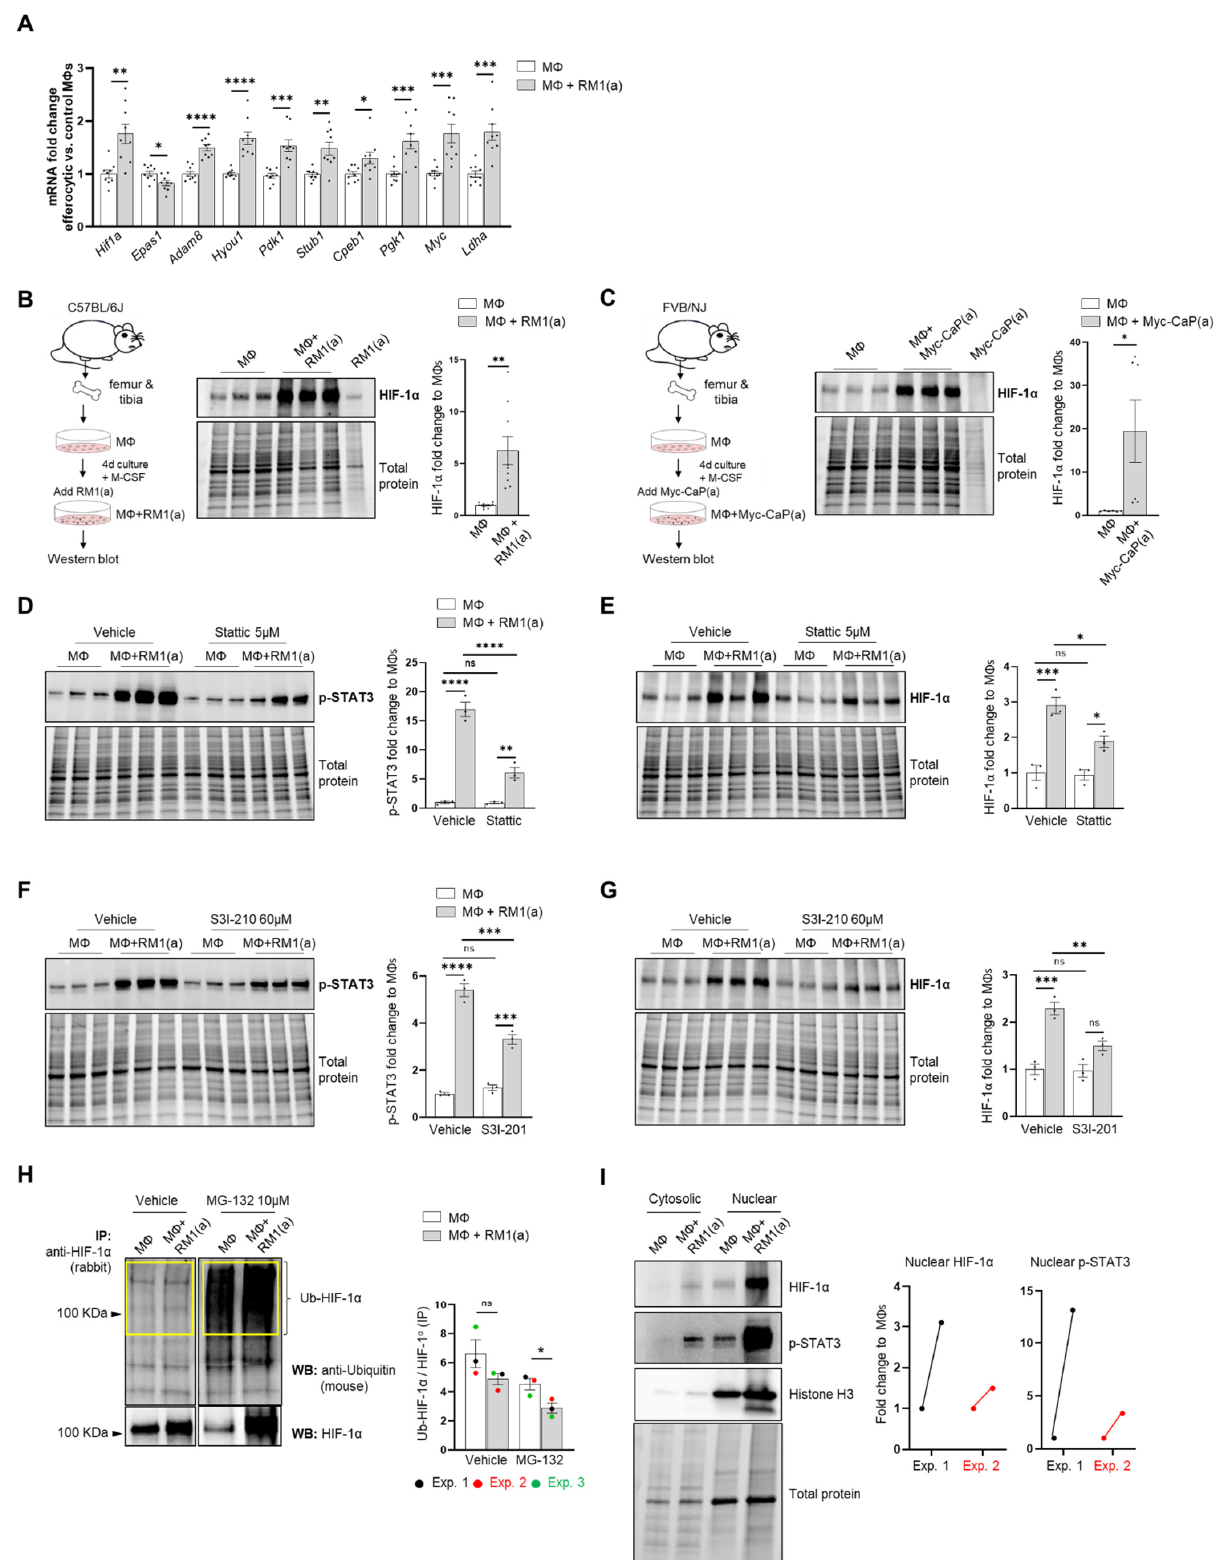
Figure 2. BM macrophage efferocytosis of apoptotic cancer cells promotes HIF-1 α stabilization through STAT3 activation. BM macrophages (M Φ ) were isolated from 4 wk old C57BL/6J or FVB/NJ mice and co-cultured with apoptotic RM1(a) or Myc-CaP(a) cells for 16–18 h. ( A ) mRNAs isolated from efferocytic and control BM macrophages were analyzed by real time quantitative PCR